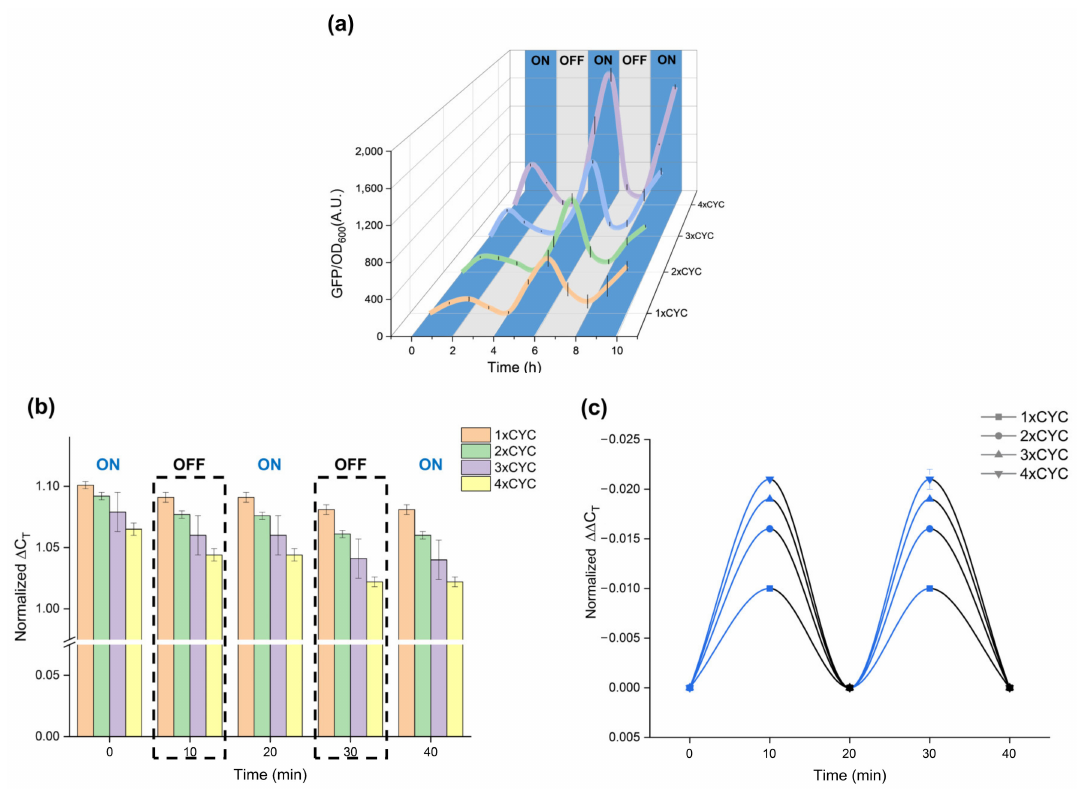
Figure 6. Temporal behavior of pYLBI system. ( a ) GFPMut3 activity levels in 1~4 × CYC samples were illuminated or kept in the dark for the indicated times (2 h). Grey areas represent the dark state (‘OFF’) while the blue areas (illumination ‘ON’, all blue). ( b ) GFPMut3 mRNA levels were quantified by qPCR from 1~4 × CYC samples treated with blue light or kept in the dark with an on-off cycle of 10 min intervals. Normalized ∆ C T values are shown. ( c ) Normalized ∆∆ C T value processed for 10 min in the activated (Blue line) or deactivated (Dark line) state. Error bars indicate Means ± S.D. (n =